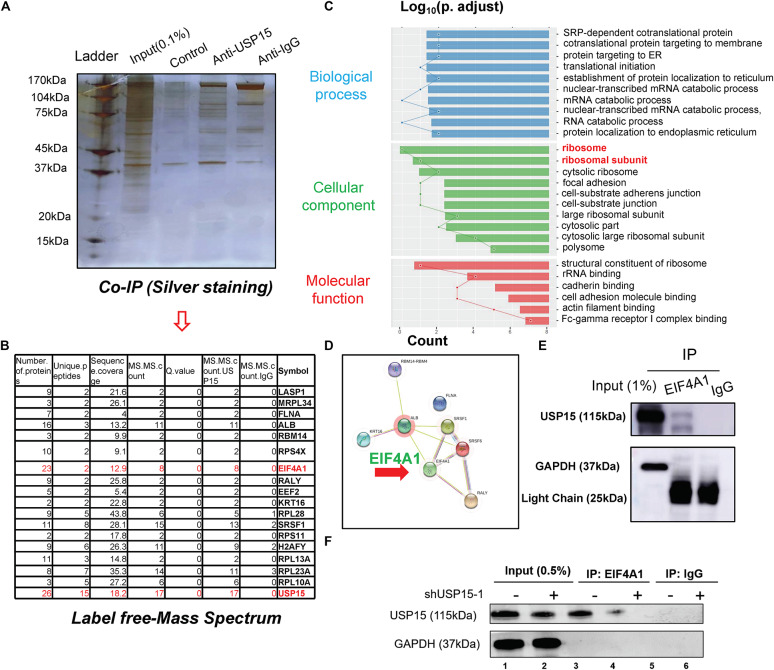
The interactome analysis of USP15. (A) A coimmunoprecipitation assay was performed to identify the USP15-interacting proteins. The eluted protein was identified by silver staining. (B) A mass spectrum analysis was performed, and 18 specified USP15-interacting proteins were identified. (C) A Gene Ontology assay demonstrated that the differentially expressed genes were mainly distributed in ribosomes. The GO assay was performed in http://geneontology.org/. (D) A protein interaction network assay was performed to identify the central proteins in the USP15 interactome. This assay was performed in https://string-db.org/. (E) An immunoprecipitation assay was performed to illustrate the interaction between EIF4A1 and USP15. EIF4A1 was used as a bait. The GAPDH protein presented a strong band in input group while IgG light chain only presented in IP group. (F) An immunoprecipitation assay was performed after silencing USP15. EIF4A1 was used as a bait. The GAPDH protein presented a strong band in input group while absent in IP group.